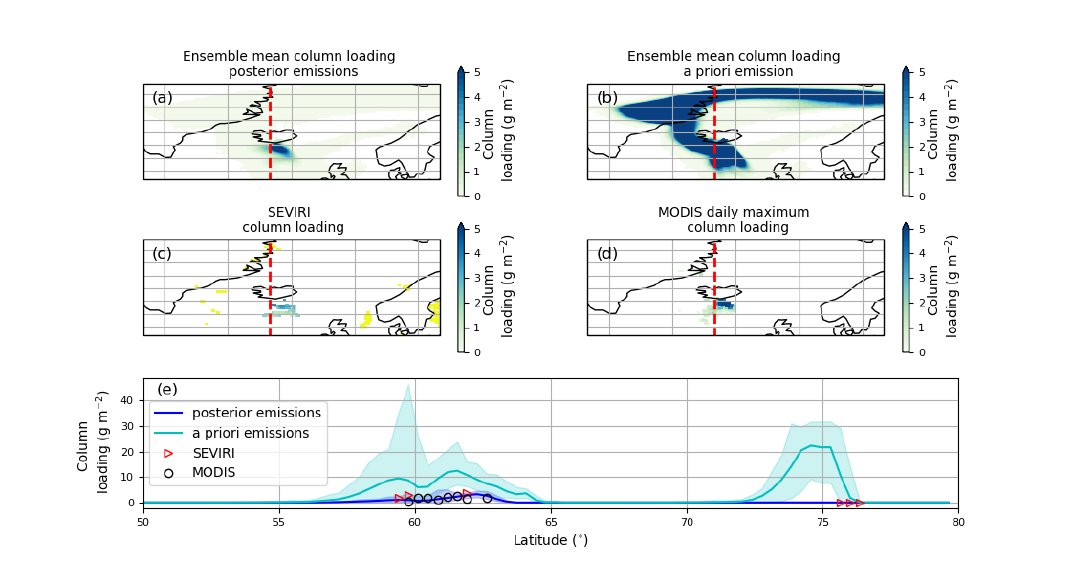
Figure 8. ( a ) Ensemble mean ash column loading at 1800 UTC 23 May 2011 for simulations run with emission profiles determined using InTEM with matching ensemble meteorology at 1800 UTC 23 May 2011, ( b ) Ensemble mean ash column loading at 1800 UTC 23 May 2011 for simulations run with a priori emission profile and ensemble meteorology, ( c ) SEVIRI ash column loading (yellow shading indicates grid boxes that are classified as clear sky) ( d ) Daily MODIS maximum ash column loading for 23 May 2011, ( e ) Ash column loading profile along the cross section indicated by the red dashed line in panels ( a – d ) for the posterior ensemble (blue), a priori ensemble (cyan), SEVIRI ash column loading (red triangles) and MODIS ash column loading (black circles). The shading indicates the range of column loading in the